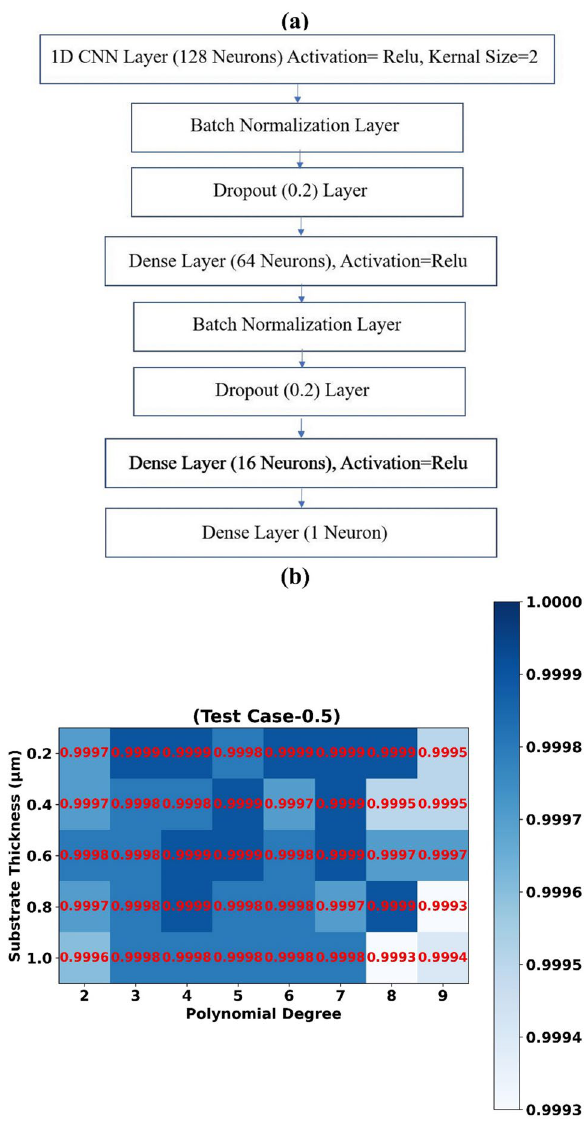
Figure 5. ( a ) Layer structure of 1D-CNN regressor ( b ) Prediction accuracy (R 2 Score) of 1D-CNN Regressor models trained for assorted values of substrate thickness and polynomial degree features (Test Case